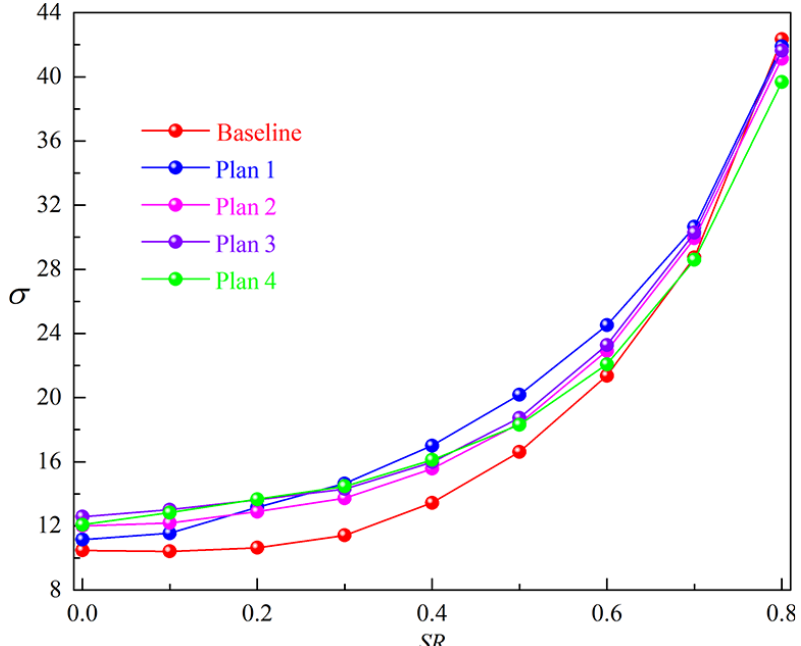
Figure 12. Distribution of cavitation threat characteristics for various suppression slots.